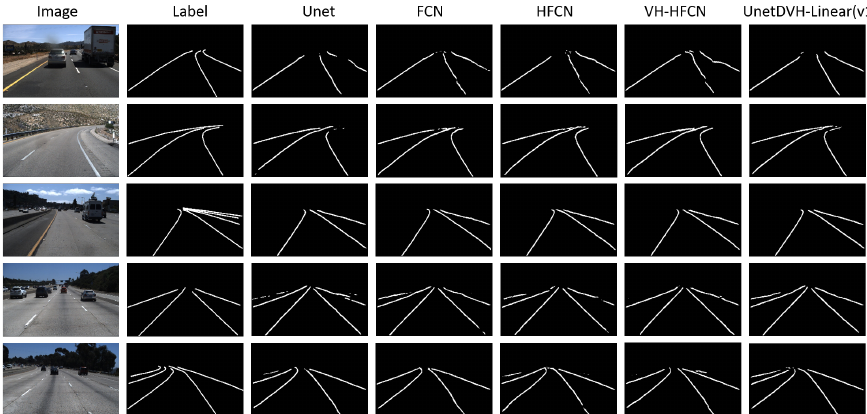
Figure 7. Example of segmentation results on the TuSimple lane dataset. The first column is the input images. The second column is the segmentation masks of the images. The third column to the sixth column is comparative experimental models. The last column is the model that performs best in our designed models.